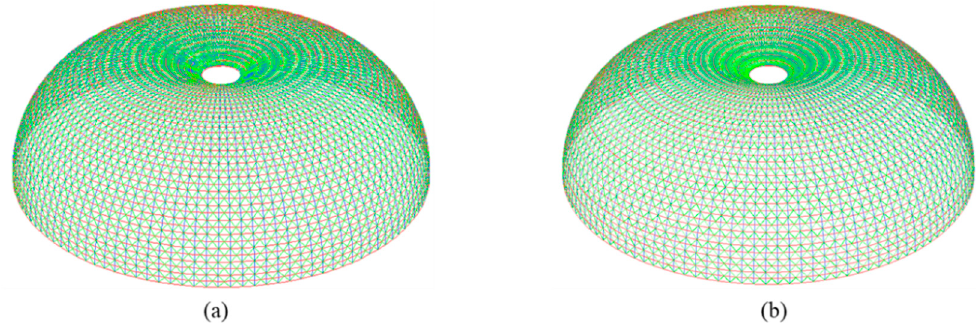
Figure 4. Finite element models in Strand7: ( a ) the straight member model; ( b ) the curved member model.